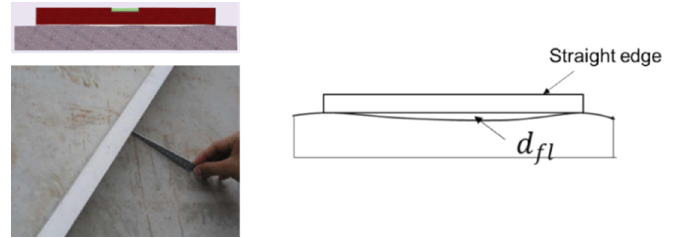
Figure 8. Measurement of flatness d fl of a prefabricated element.